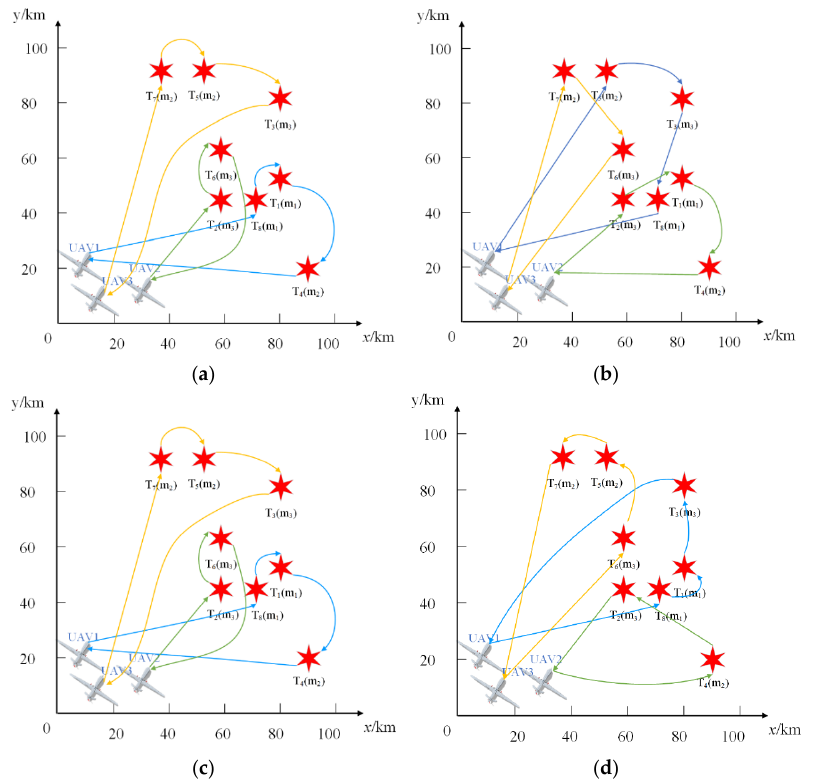
Figure 10. The schematic diagram of task assignment results of two algorithms: ( a ) OLPDHS; ( b ) SAHS; ( c ) NDHS; ( d ) NGHS.